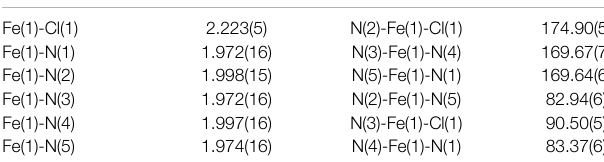
TABLE 2 | Selected interatomic distances (Å) and bond angles ( ° ) for Fe-L N3